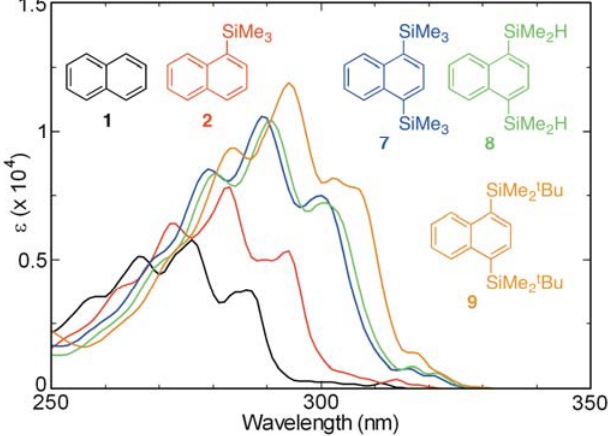
Figure 4. UV absorption spectra of 1 , 2 , and 7–9 in cyclohexane (aerated, ca. 10 − 4